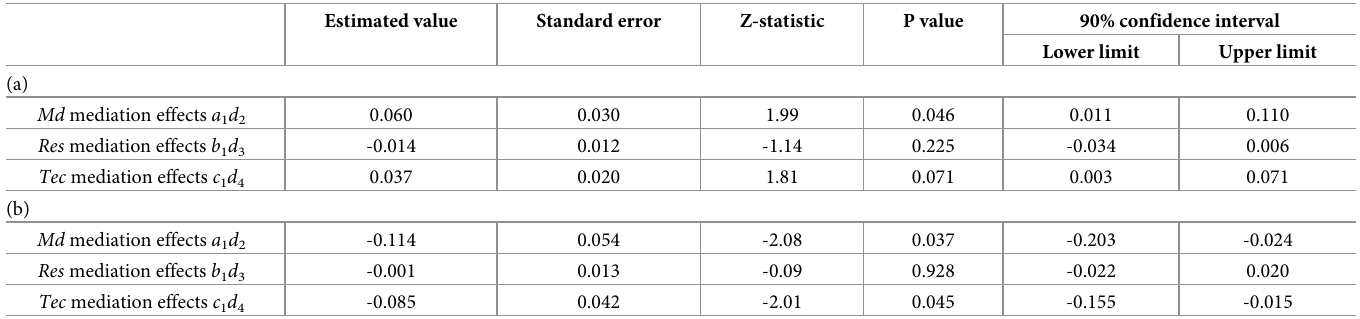
Table 6. (a): Significance test of mediation effects. (b): Significance test of mediation